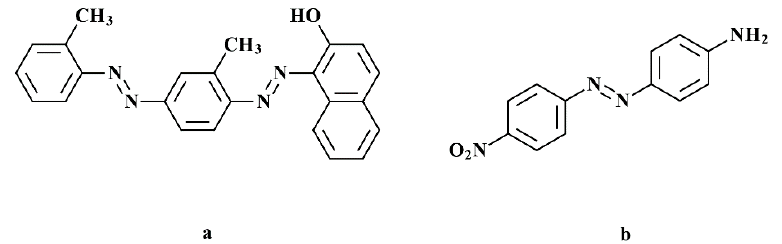
Figure 4. Chemical structures of ( a ) Sudan IV and ( b ) Disperse Orange 3 .